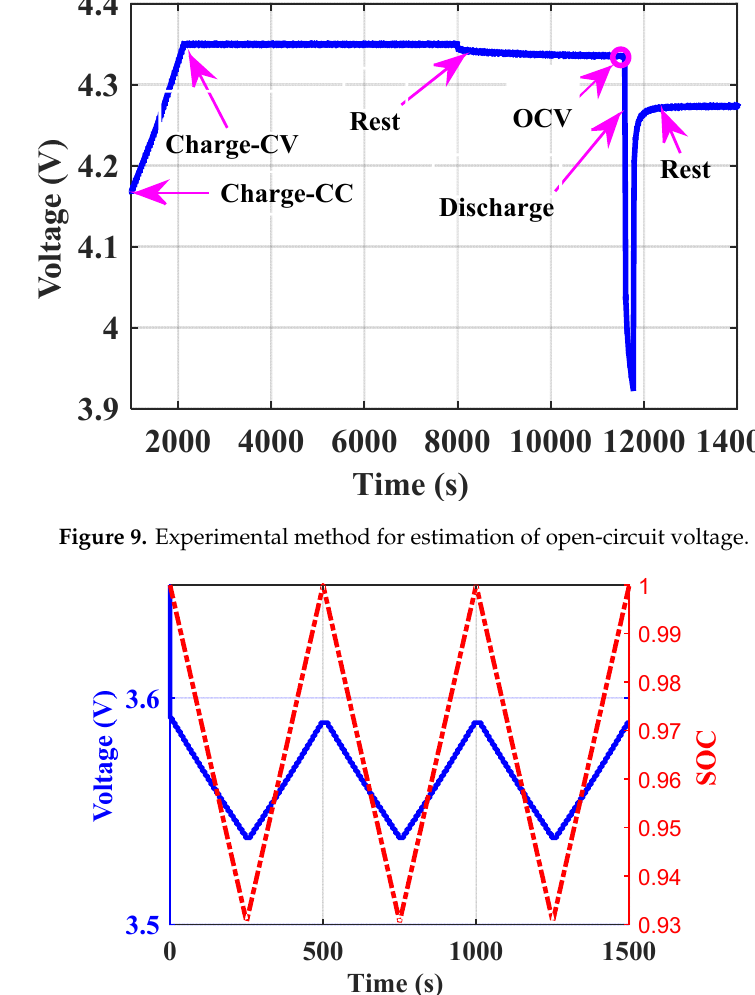
Figure 10. Trend matching between the terminal voltage and SOC of the battery.